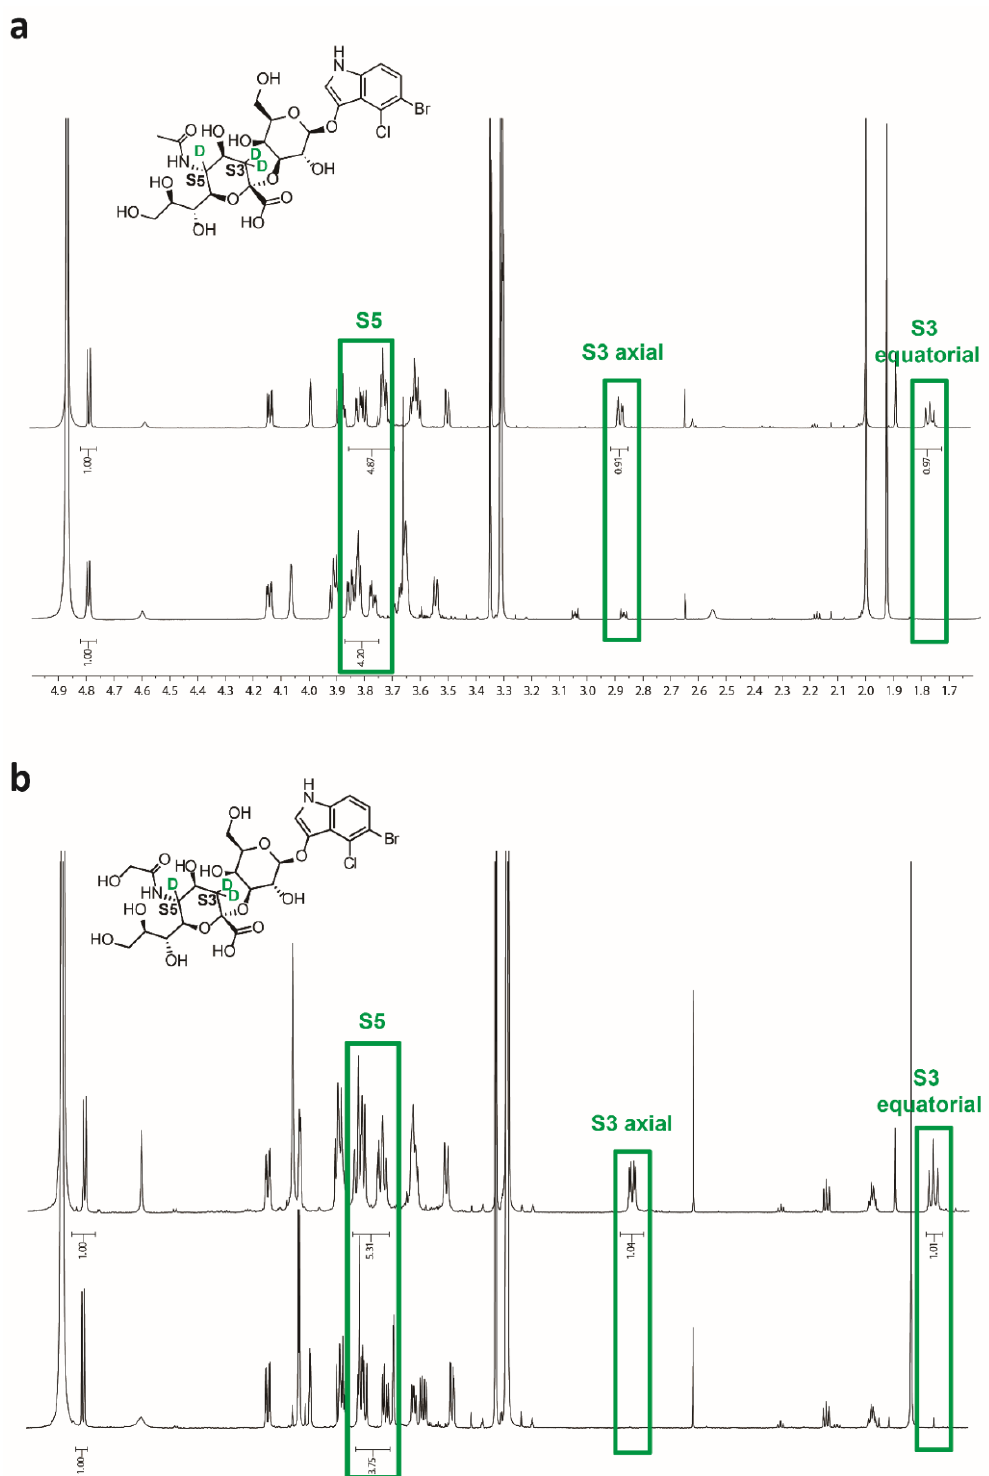
Figure 2. 1 H-NMR spectroscopic measurements of the tri -deuterated sialosides and nondeuterated sialosides: ( a ) X-Gal- α -2,3-Neu5Ac (top), compound 9a (bottom), ( b ) X-Gal- α -2,3-Neu5Ac (top), compound 9b (bottom).